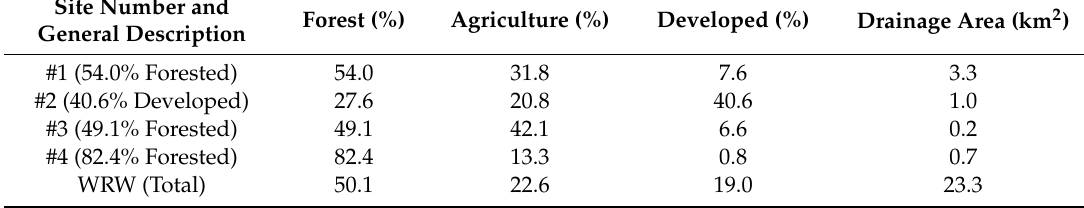
Table 1. Land use/land cover characteristics (% cover) and total drainage area (km 2 ) at four monitoring sites in West Run Watershed (WRW), West Virginia, USA. Note: land use percentages may not sum to 100%, as not every category is included (i.e., wetland, open water, etc.) and some categories are combinations of others (e.g., developed = urban + residential), or independent (e.g., impervious). Final row indicates total values for the entire watershed.